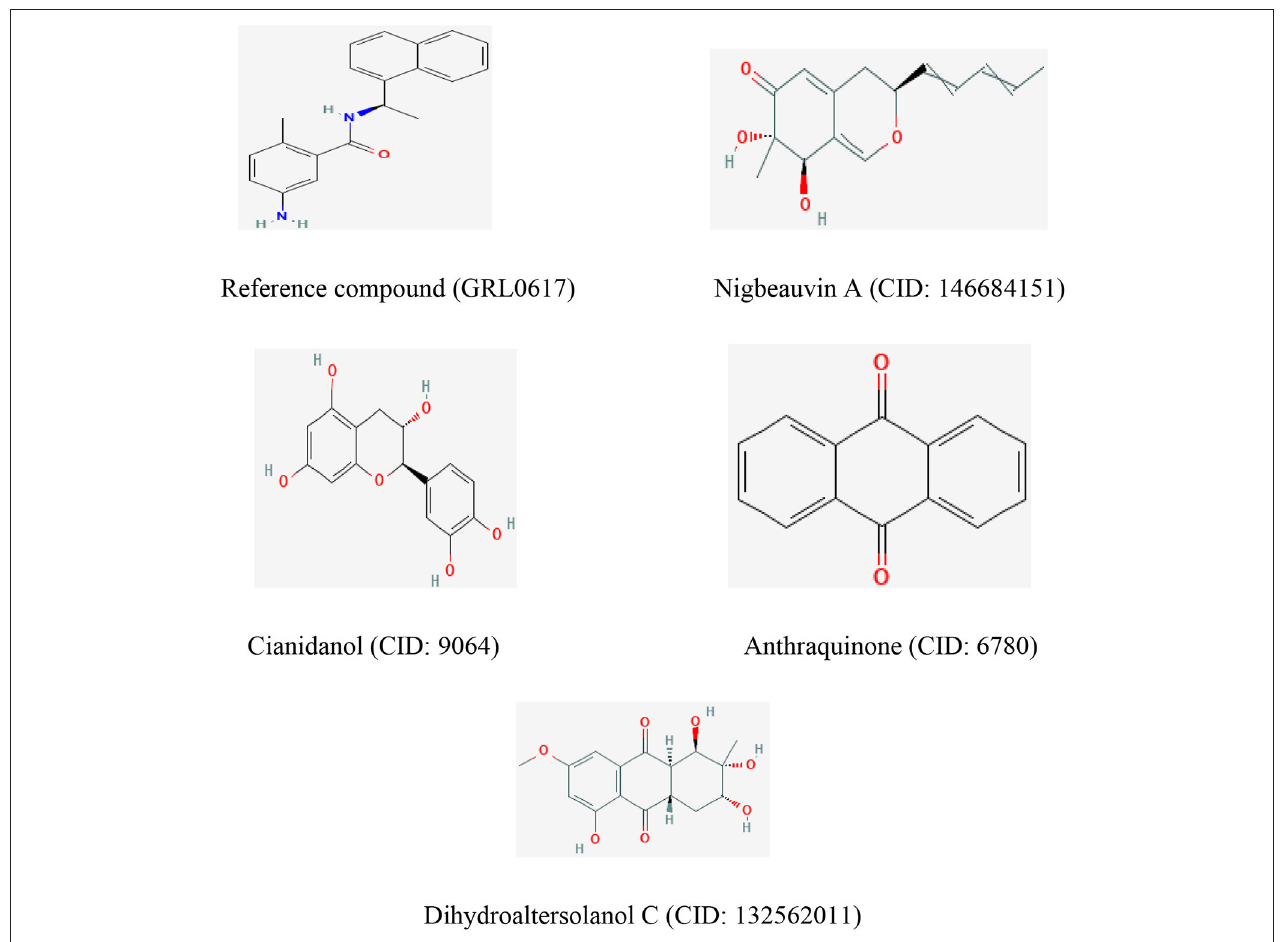
FIGURE 6 | The chemical structures of the reference compound (GRL0617) and the top four selected fungi-derived compounds retrieved from Pub-Chem (https://